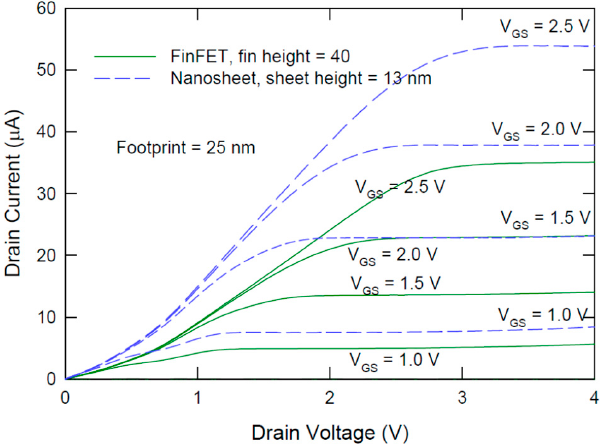
Figure 2. Comparison of experimental current–voltage characteristics of FinFET and nanosheet transistor with same footprint and headroom. The gate length of the transistors was 2 µm.